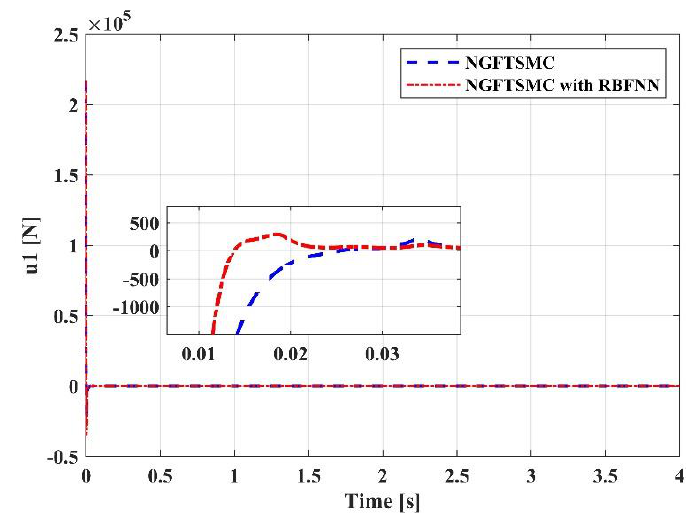
Figure 12. The performance of the control input u 1 .